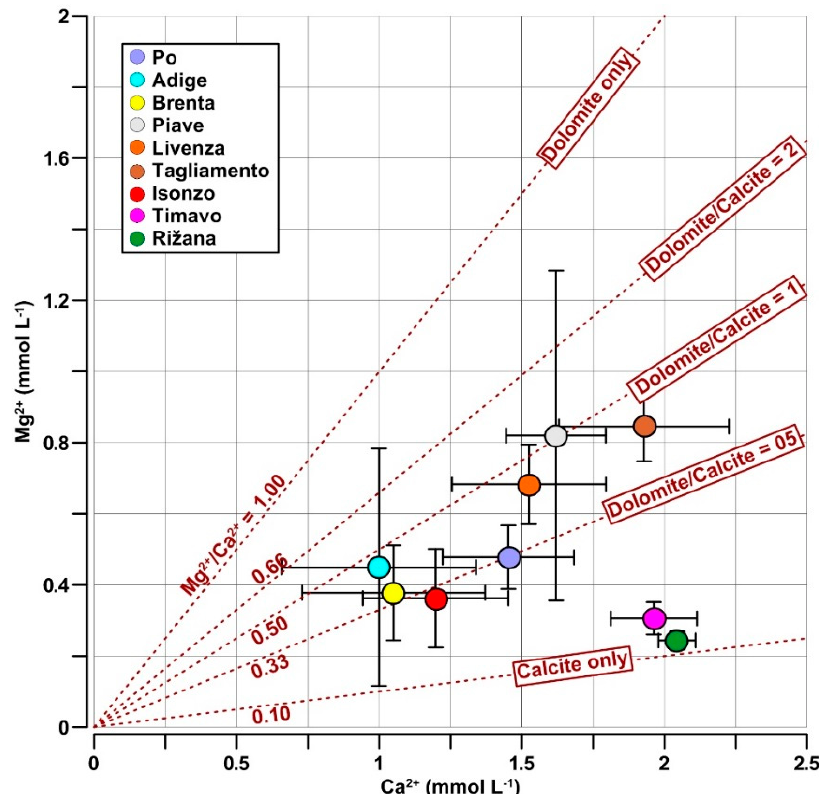
Figure 2. Mg 2+ /Ca 2+ molar ratios in river water (mean values and standard deviation) compared to theoretical values expected from weathering of carbonate rocks (calcite and dolomite). The data of Dragonja River are not included in the figure because the Mg +2 /Ca +2 ratio (=1.07) was strongly influ- enced by the intrusion of salt water at the river mouth.